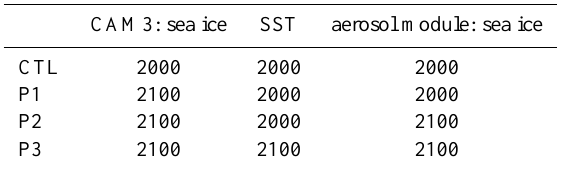
Table 2. Matrix of CAM-Oslo simulations: 2000 represents the HadISST 1980-2000 climatology, 2100 represents the 2095–2100 climatology of CCSM3 model